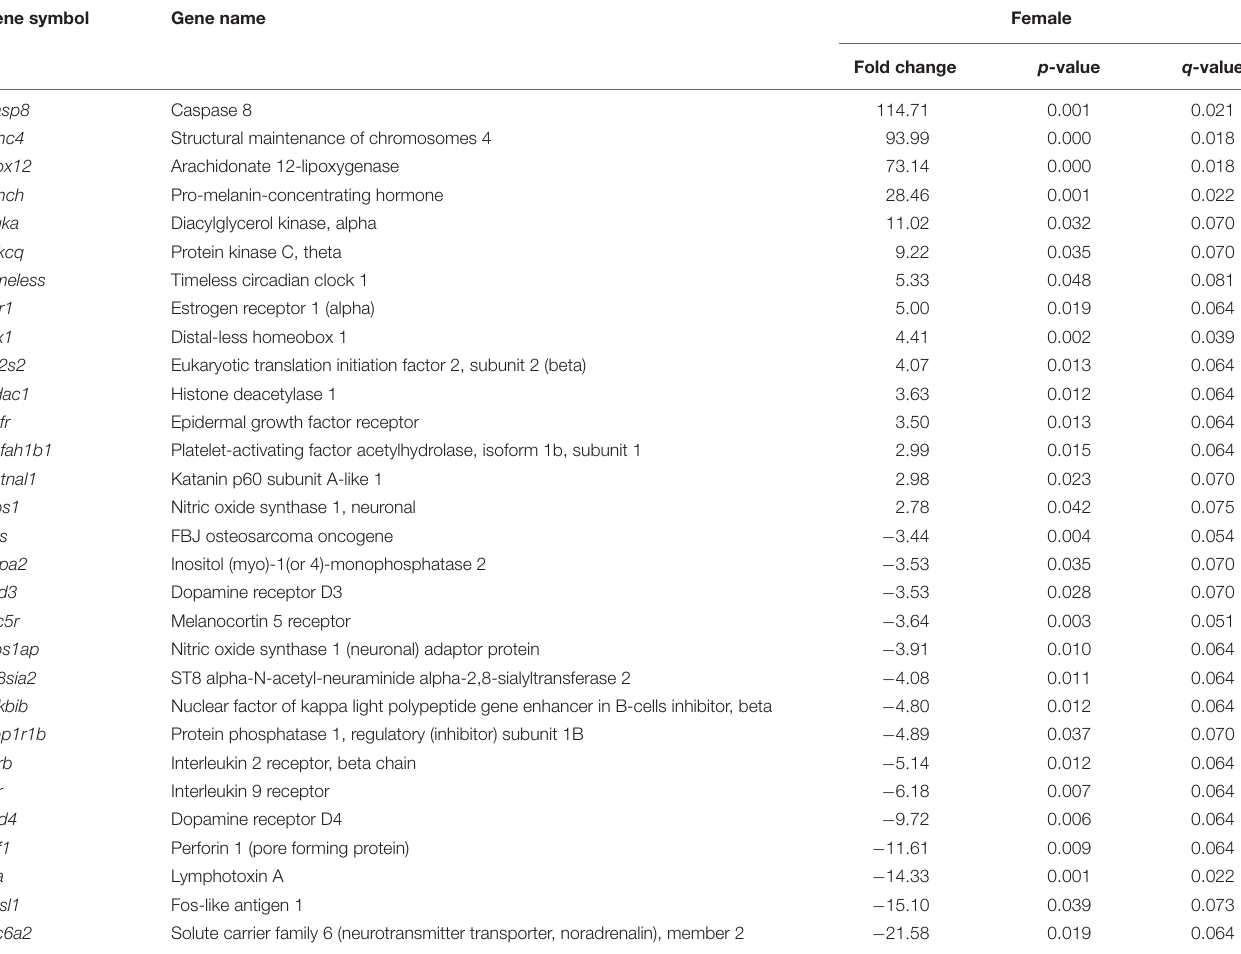
TABLE 3 | Top 30 genes significantly regulated by binge drinking in female nucleus